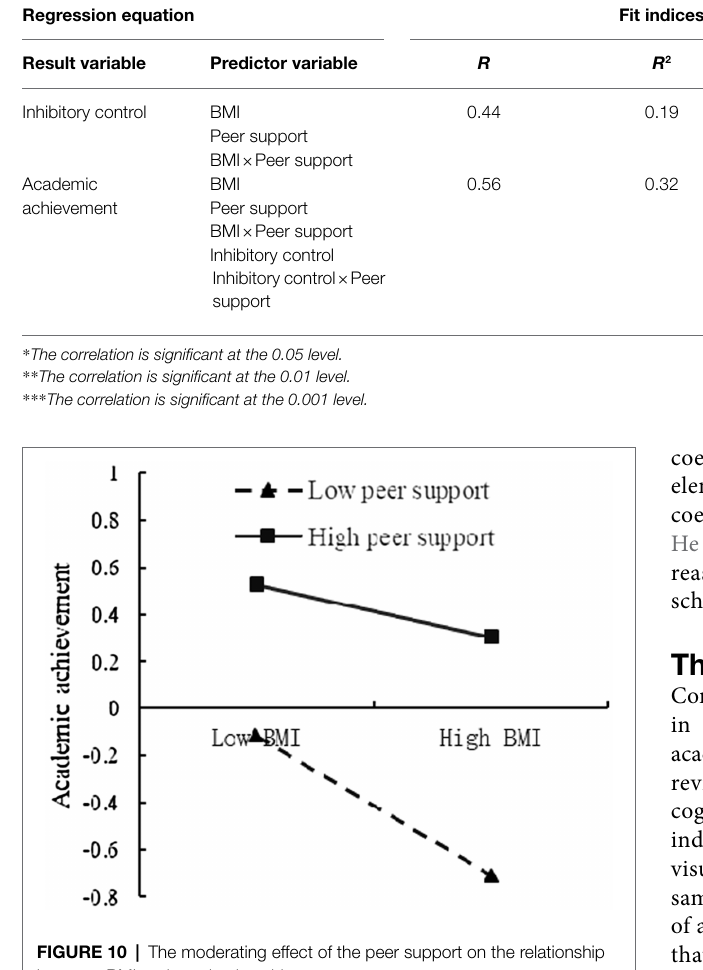
FIGURE 10 | The moderating effect of the peer support on the relationship between BMI and academic achievement.